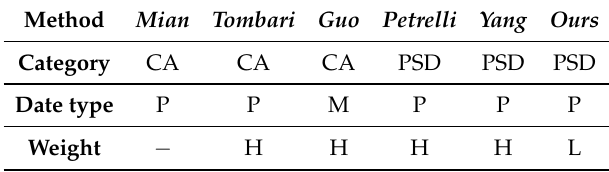
Table 2. Properties of six LRF methods. H and L, respectively, represent hand-crafted and learned methods for point weight calculation; P and M, respectively, denote point cloud and